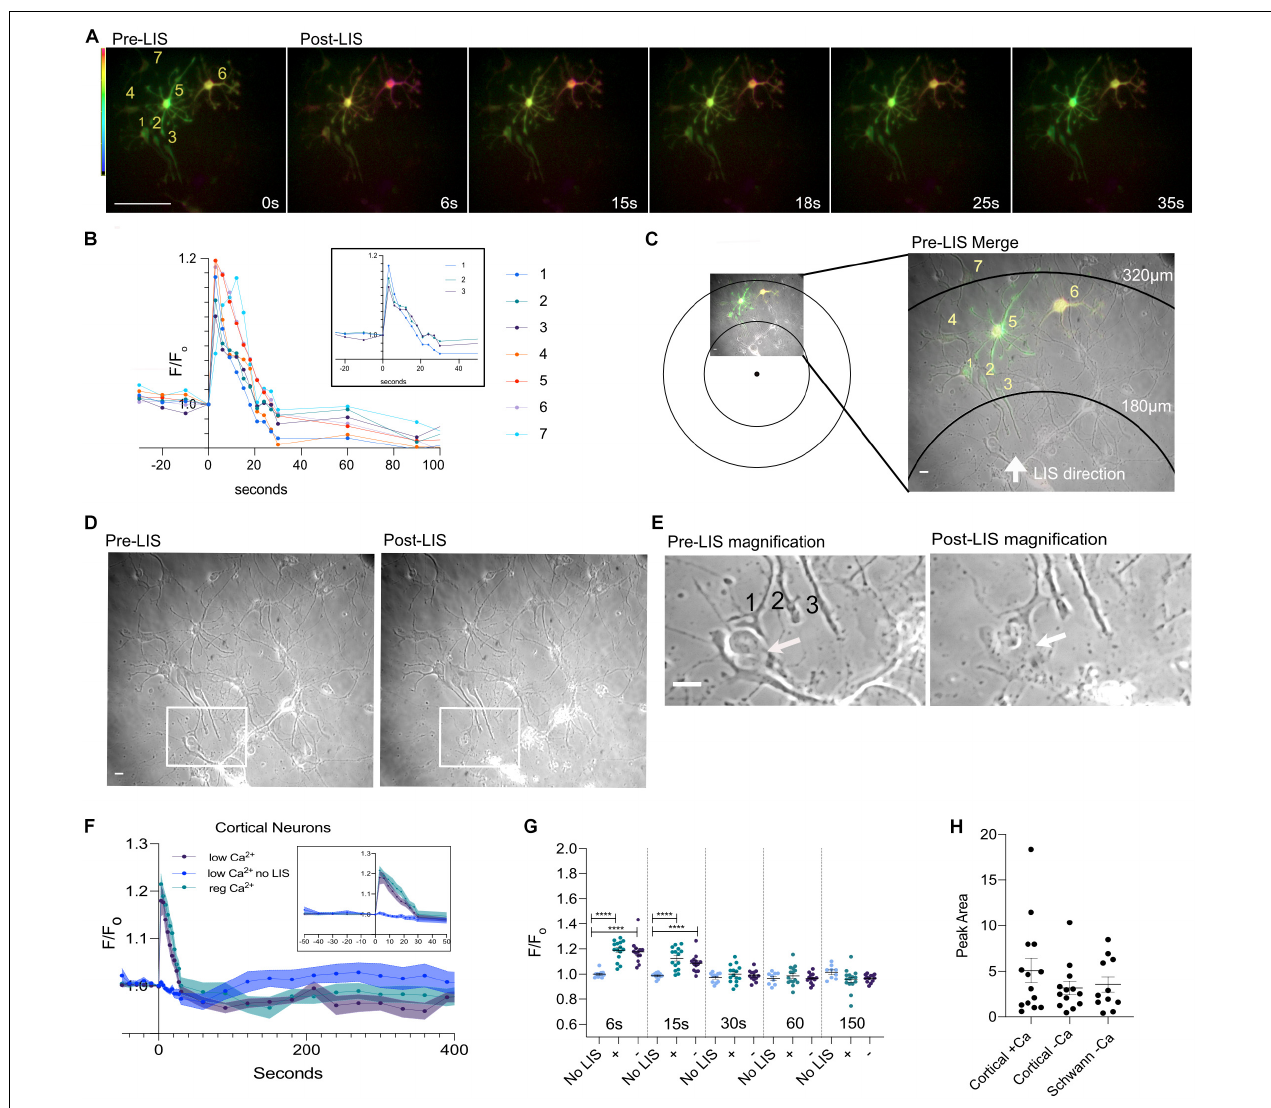
FIGURE 3 | Ratio images of DIV 8 cells at different distances from the focus. (A) Ratio images of neurons in low Ca 2 + . Seven cells are fluorescing and are numbered. Cells 5 and 6 expressed more biosensor than the rest. Scale bar = 100 µ m. (B) Ca 2 + traces of the cells in the field of view. Traces of neurons 1–3 are shown separately in an inset within the graph. (C) Pre-LIS ratiometric image and a phase image were overlayed. Concentric rings corresponding to 180 and 320 µ m from the laser focus point are shown. A magnified view of the field of view is shown to the right. Scale bar = 10 µ m. (D) Phase images of the field view pre- and post-LIS. Three axons are enclosed in a rectangular box and the enclosed region is shown magnified in (E) . Pre-LIS magnification shows a growth cone #1 surrounds a cell body. After LIS the growth cone appears intact despite necrosis of the cell body. Scale bar = 10 µ m. (F) Average F/F o of cortical neurons in regular Ca 2 + (teal, n = 15 cells) and in low Ca 2 + (purple, n = 13) conditions. No shockwave controls were imaged in low Ca 2 + (blue, n = 12). The thickness of each curve is representative of the standard error mean. An inset of the first 50 s is shown within the graph. (G) Individual F/F o values are plotted for cells at 6, 15, 30, 60, and 150 s post shockwave. No LIS indicates that cells have not been shockwaved. Those cells were in low Ca 2 + HBSS. A plus sign (+) indicates cells were in regular Ca 2 + Hanks Buffer Saline Solution when shockwaved. A minus sign (-) is used to represent that cells were in low Ca 2 + HBSS when shockwaved. Peak values are significantly different between cells receiving LIS and No LIS controls. **** p = 0.0001. (H) The integral of the time under the transient is shown for cortical cells shockwaved in Ca 2 + (+Ca) and without (-Ca). DRG Schwann cells are included for comparison, orange points. The average area is 5.1 ± 1.3 ( N = 14), 3.1 ± 0.7 ( N = 13), 3.5 ± 0.8 ( N = 11),